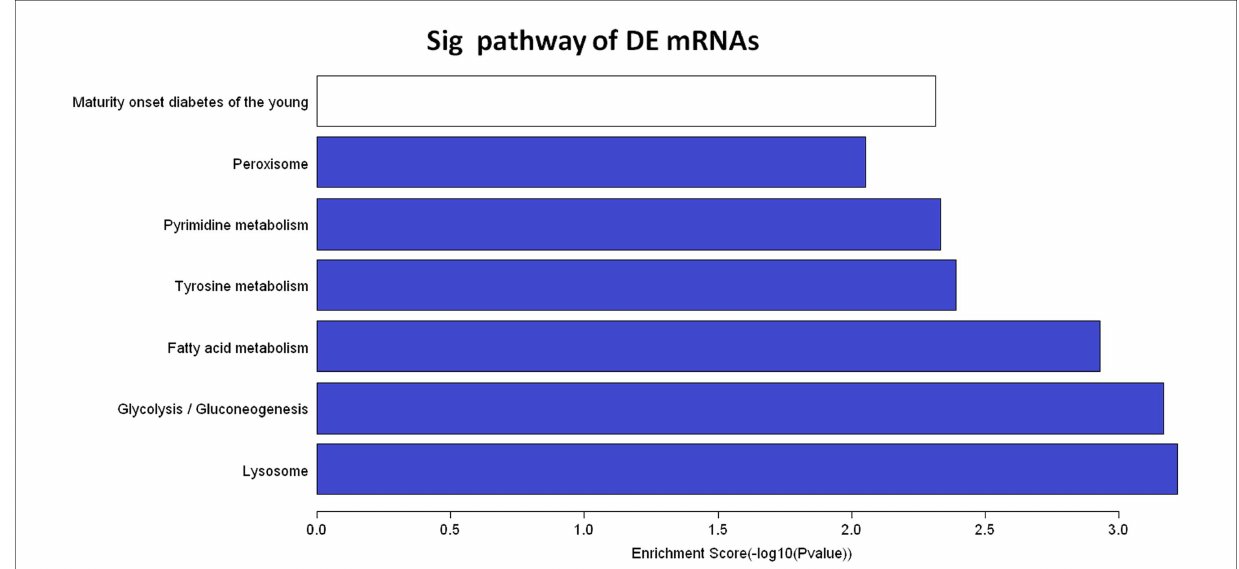
Figure 3. Pathways of dysregulated mRNAs with the enrichment scores ( 2 log10 ( P -value)) . 2. The bar plot shows the enrichment scores ( 2 log10 ( P -value)) value of the significant enrichment pathways. The white bar shows the pathway in which the up-regulated mRNAs were found to be involved and the blue bars show the pathways in which the down-regulated mRNAs were found to be involved. Pathway analysis involves mapping genes to KEGG pathways. The P -value denotes the significance of the correlation between the pathway and the conditions. Most of the shown here are related to metabolism, which indicates that the varicose veins may be a metabolic disease.